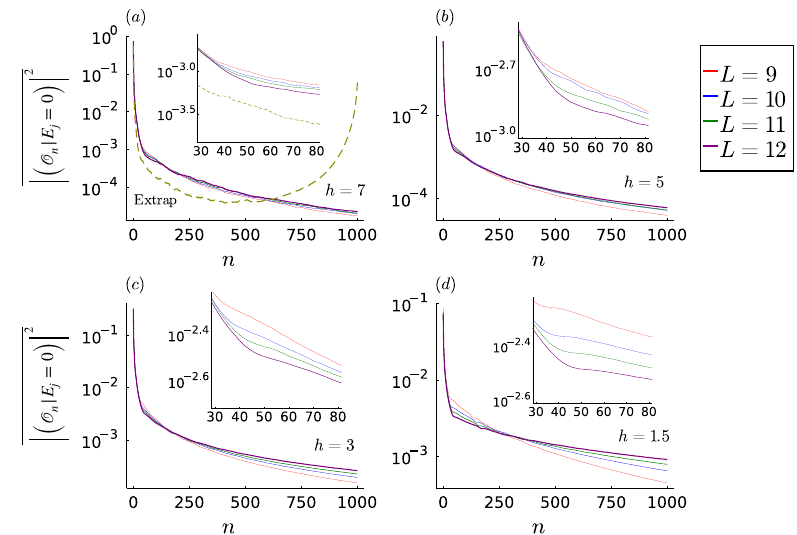
Figure 7: The disorder-averaged wavefunction profile of the zero mode obtained = 1000, several system sizes L and disorder from the b for the Krylov order n n max strengths (a) h = 7, (b) h = 5, (c) h = 3 and (d) h = 1.5. Insets: same data as in the main figures but zoomed-in in the range of n = 30-80. In (a), we also show the disorder-averaged zero mode obtained from the extrapolated b n